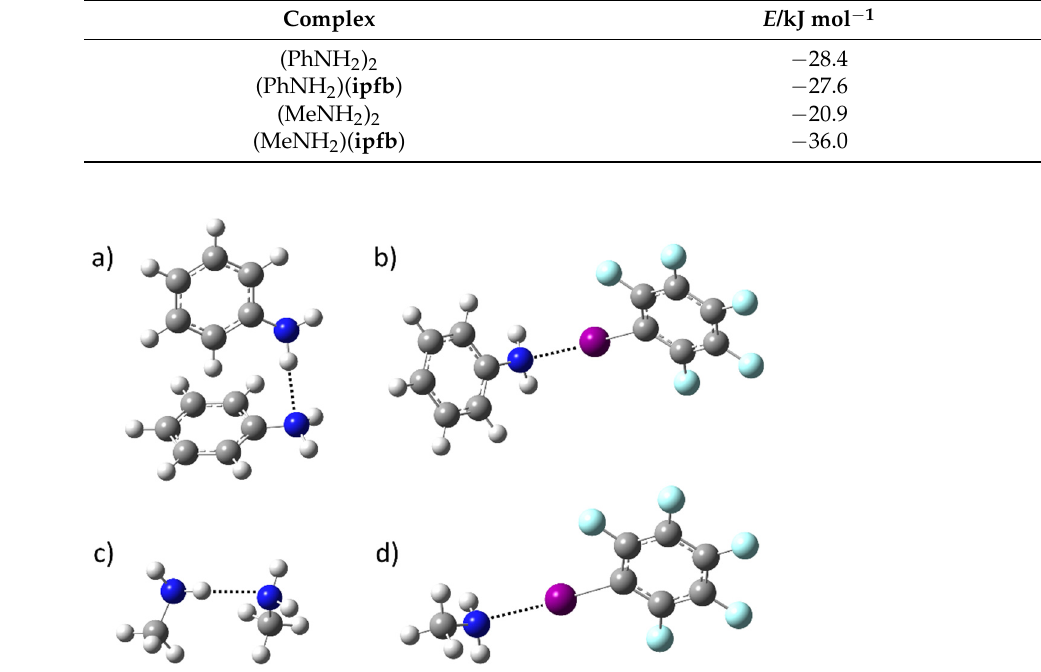
Table 2. Binding energies of (amine) 2 dimers and (amine)( ipfb ) complexes in vacuo.